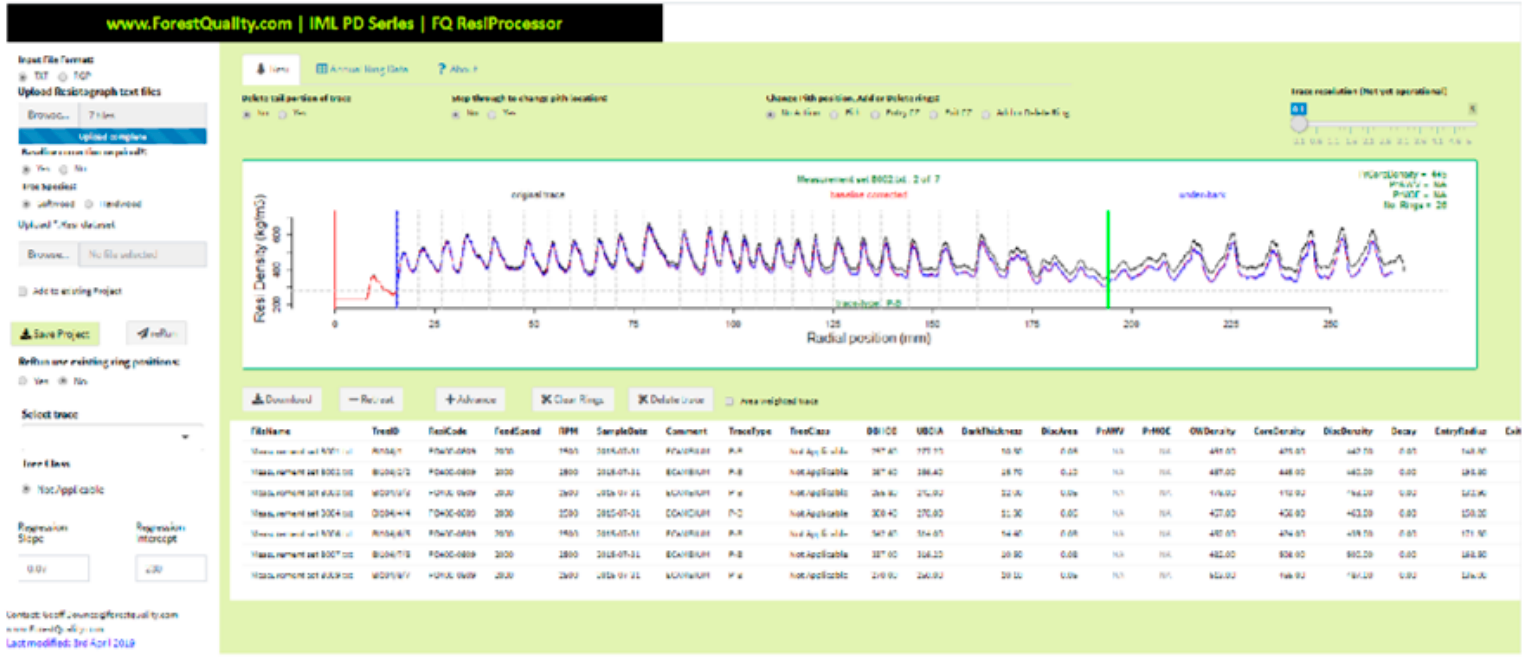
Figure 5. User interface of a web-based platform for processing Resi traces to obtain trace-level metrics.